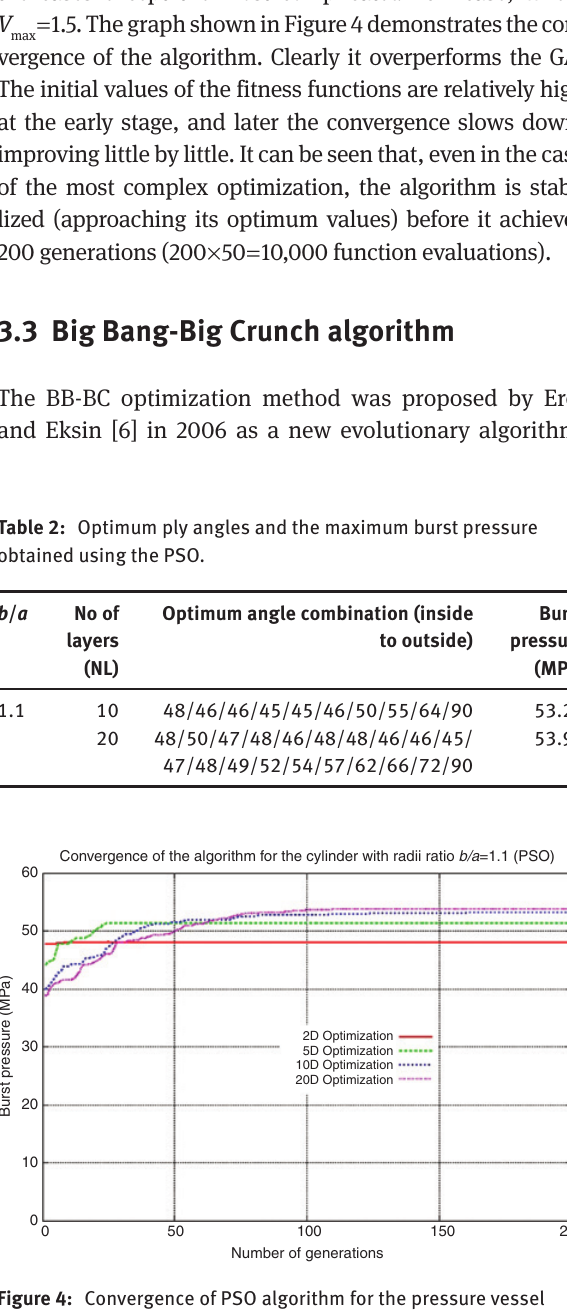
Figure 4: Convergence of PSO algorithm for the pressure vessel with a radii ratio b / a = 1.1.